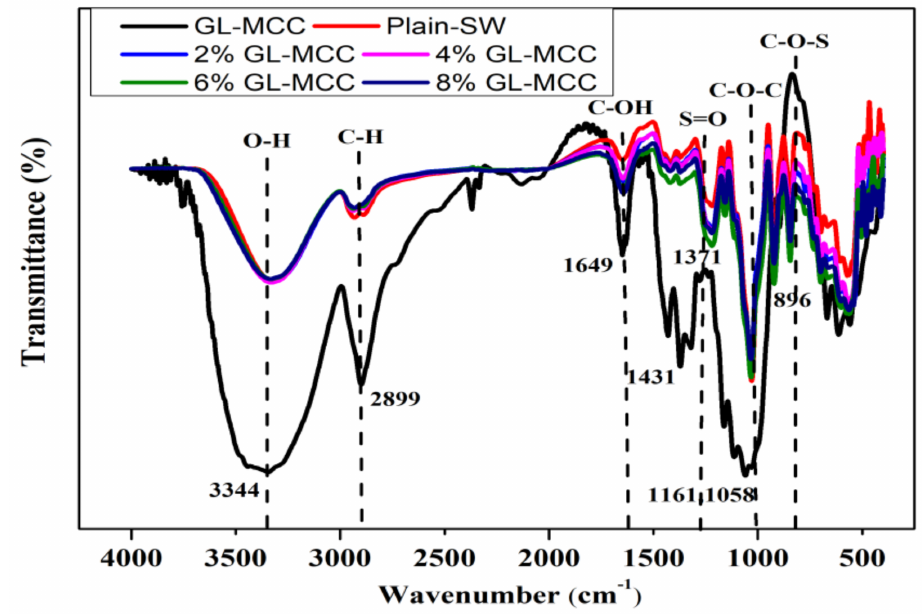
Figure 9. Fourier Transforms Infrared Spectroscopy (FT-IR) characterisation of macroalgae (SW) / polysaccharide microfibre (GL-MCC) biopolymer